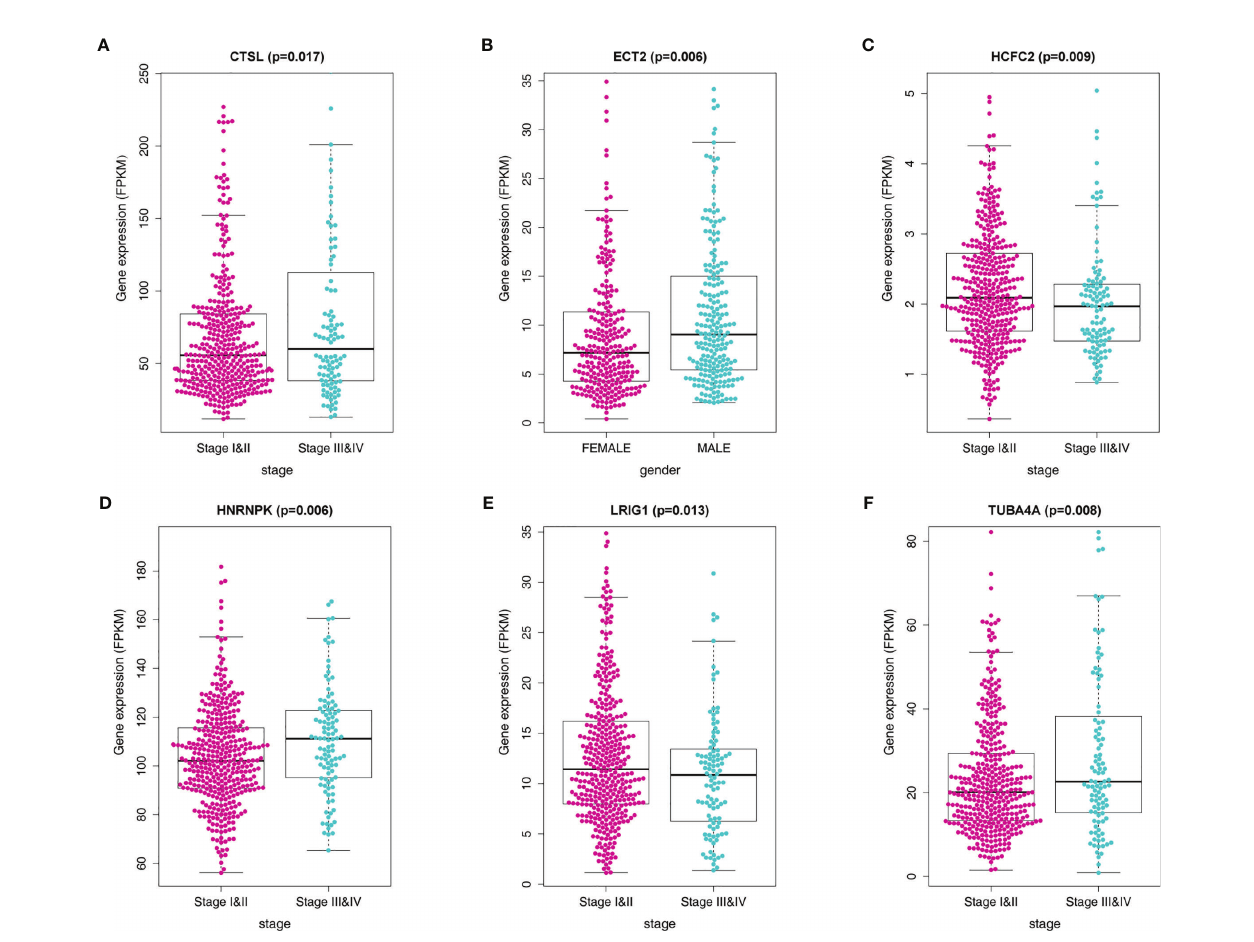
FIGURE 6 | Correlation of the MRG mRNA expression levels with demographic and clinicopathological characteristics of LADC patients. (A) Correlation between CTSL mRNA levels and disease stage. (B) Correlation between ECT2 mRNA levels and gender. (C) Correlation between HCFC2 mRNA levels and disease stage. (D) Correlation between